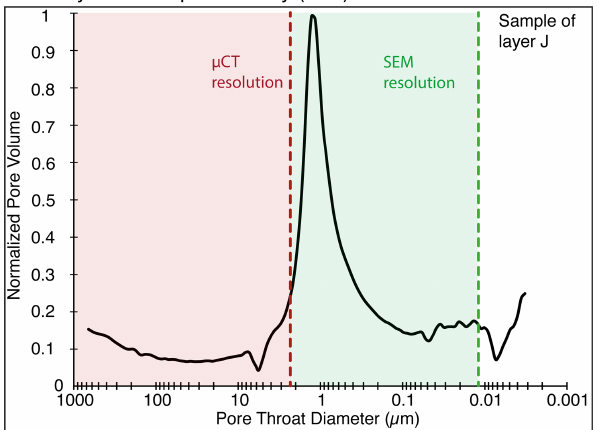
Figure 8. Distribution of the pore throat diameters of a sample of the aeolian facies in layer J obtained from mercury intrusion porosimetry (MICP).